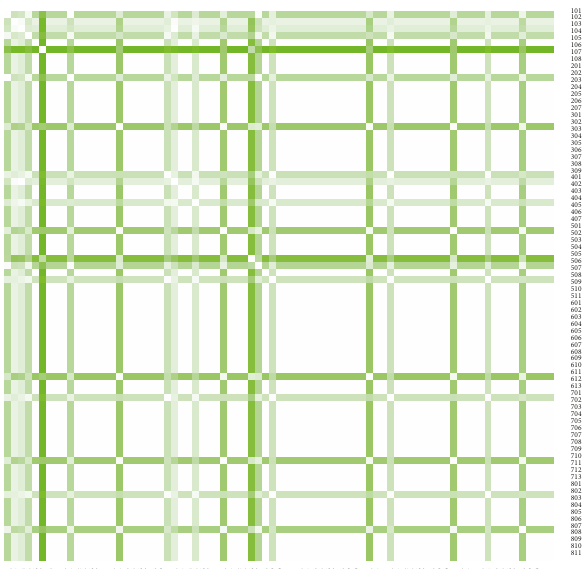
Figure 9: The distance matrix of the similarity of the districts for the female sex in 1996.